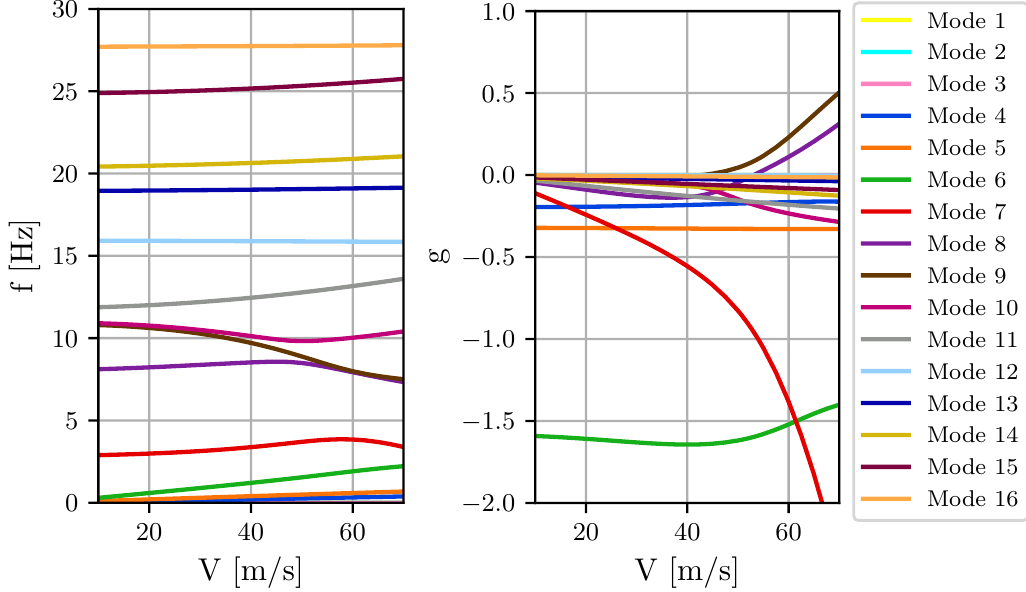
Figure 17. Frequency and damping trends of the FBC for the first 16 eigenmodes and a speed range from 10 m/s to 70 m/s.